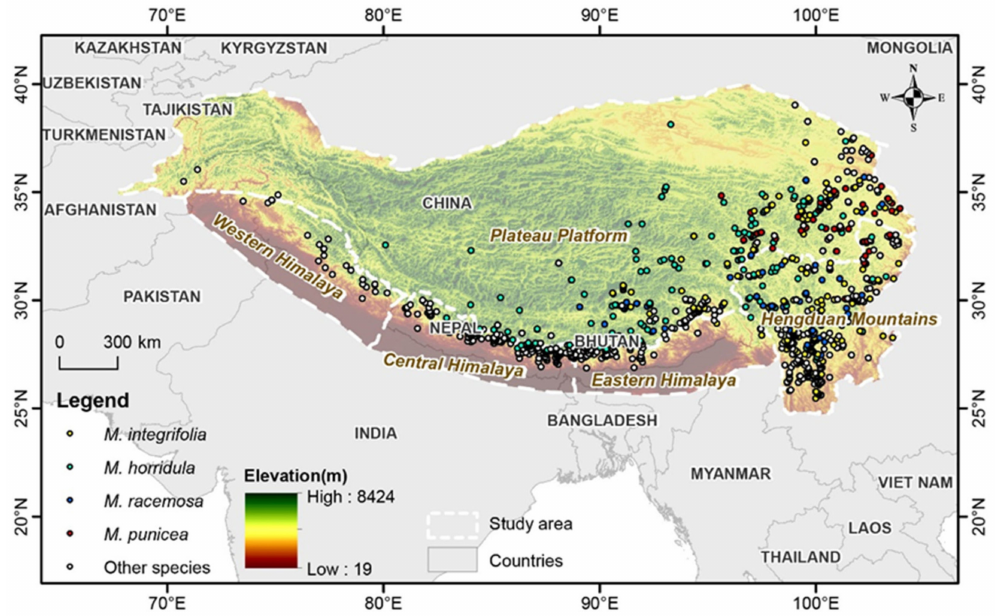
Figure 2. The presence points of Meconopsis species in the study